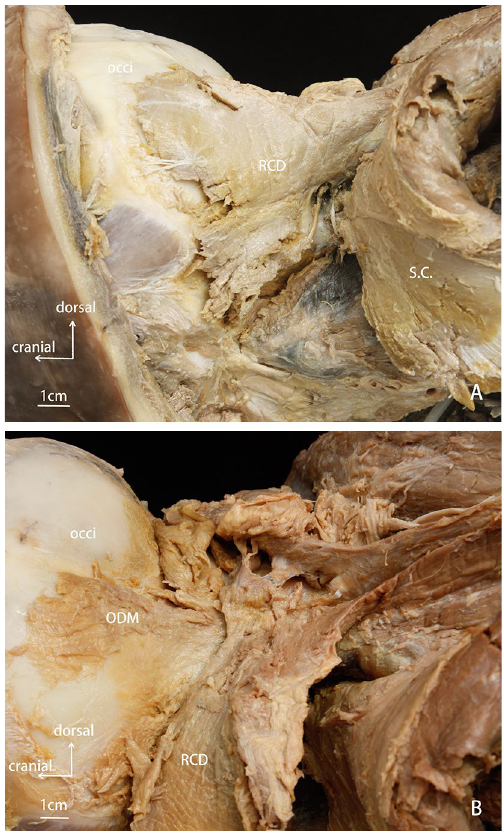
Figure 2. Anatomical dissection of the suboccipital region of the N.asiaeorientalis . ( A ) superficial layer of the suboccopital musculature. ( B ) deep layer of the suboccipital musculature. occi: occiput. RCD: rectus capitis dorsalis. S.C.: semispinalis capitis. ODM: occipital-dural muscle.